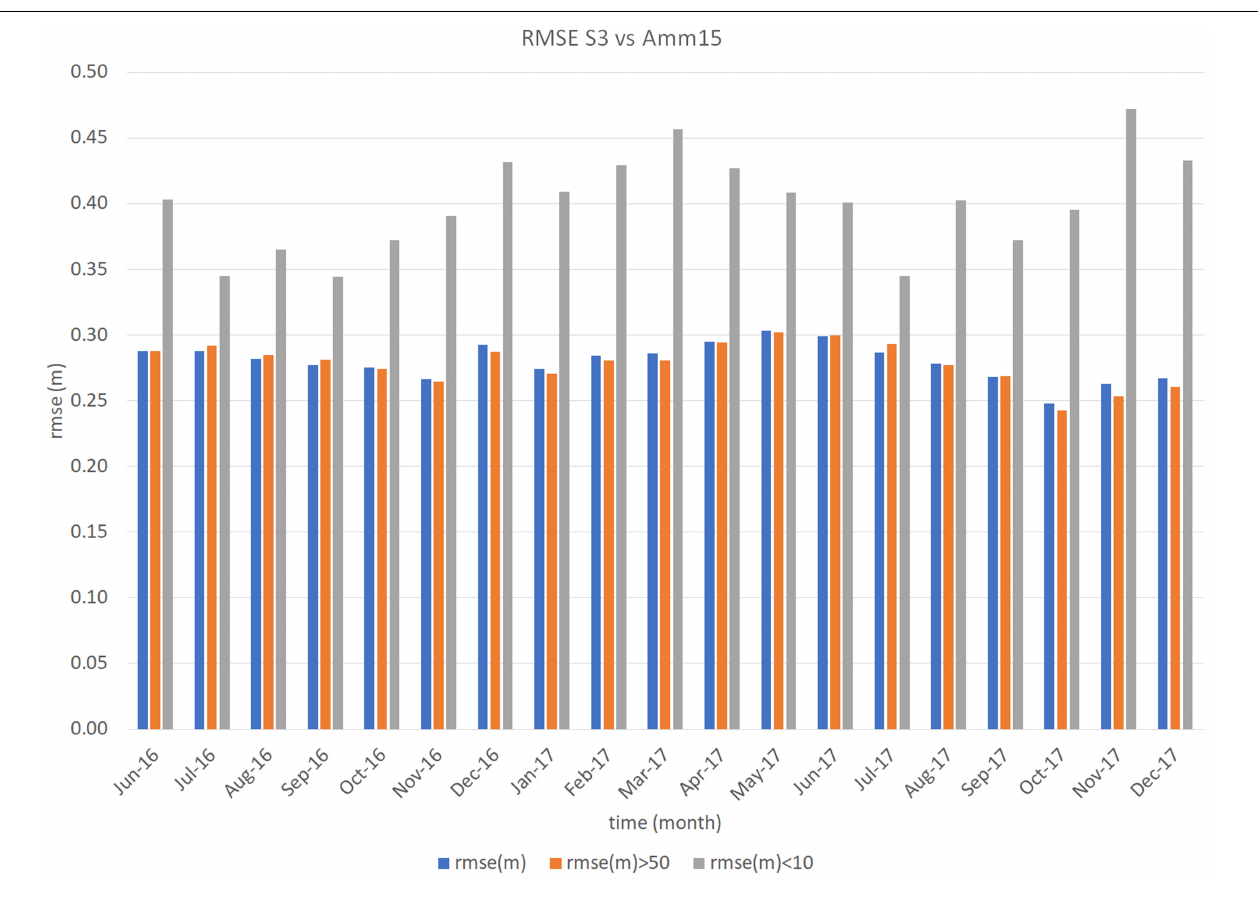
and − 0.15 m for C2 between June 2016 and September